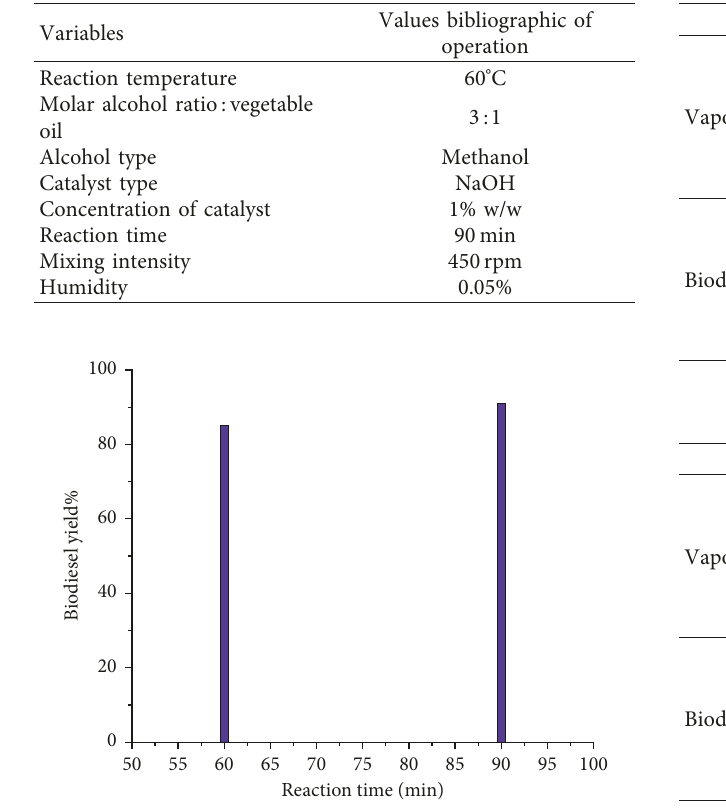
Figure 5: Biodiesel yield as a function of reaction time.